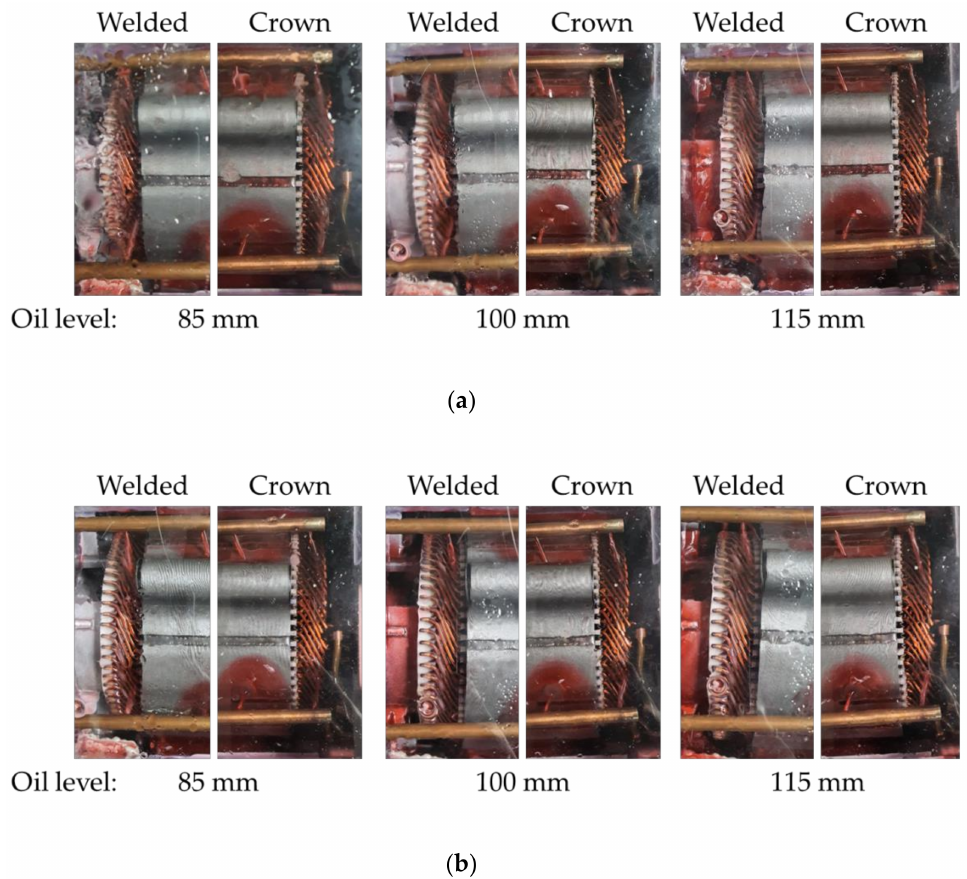
Figure 13. Oil flow according to oil level at 60 ◦ C, 0.084 kg/s: ( a ) 900 rpm; and ( b ) 1200